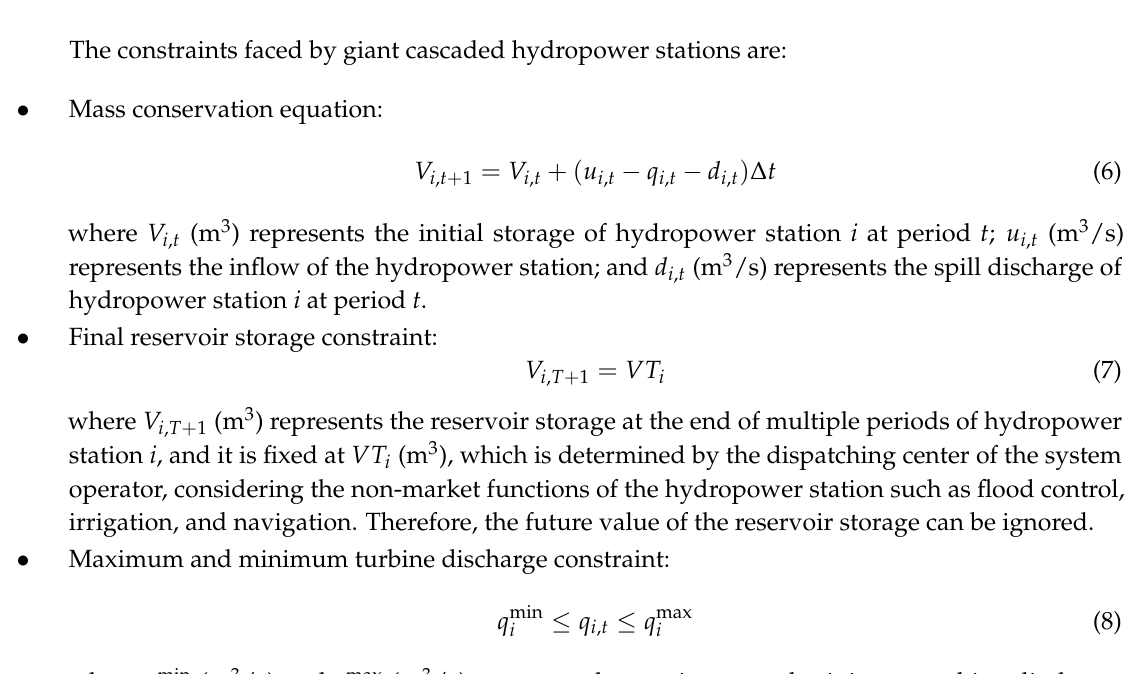
Figure 3. The characteristic curve of the relationship between water head and water volume used per kiloWatt ‐ hour.